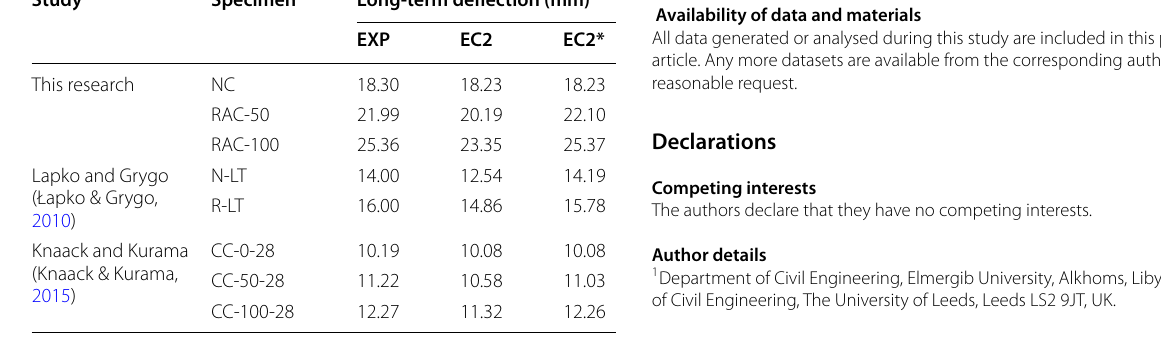
Table 7 Comparison between experimental results and predictions from the proposed analytical approach